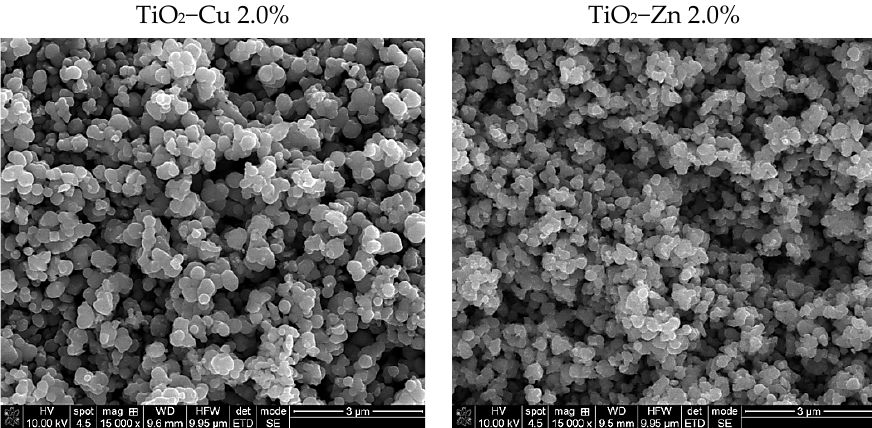
Figure 8. SEM images of the thermally treated samples at 500 °C 1h.